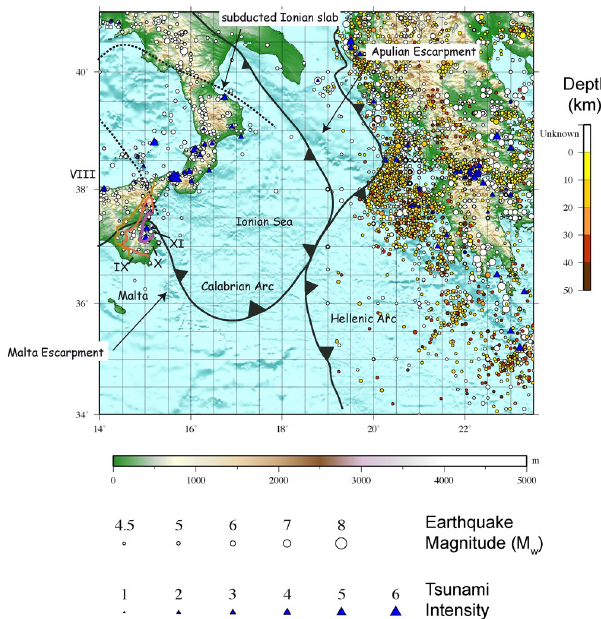
Fig. 1. Seismicity and main geodynamic features of the Ionian re- gion with the main geological features along the coast of Sicily and Calabria. The historical earthquakes have been compiled by suitably combining and homogenizing different national catalogues (see in particular CPTI Working Group, 2004; Papaioannou et al., 2000; Papazachos et al., 2007). Historical tsunamis are from Tinti et al. (2001b, 2004). The contour lines of maximum felt macroseis- mic intensity (over IX) for south-eastern Sicily are also shown (after Boschi et al.,